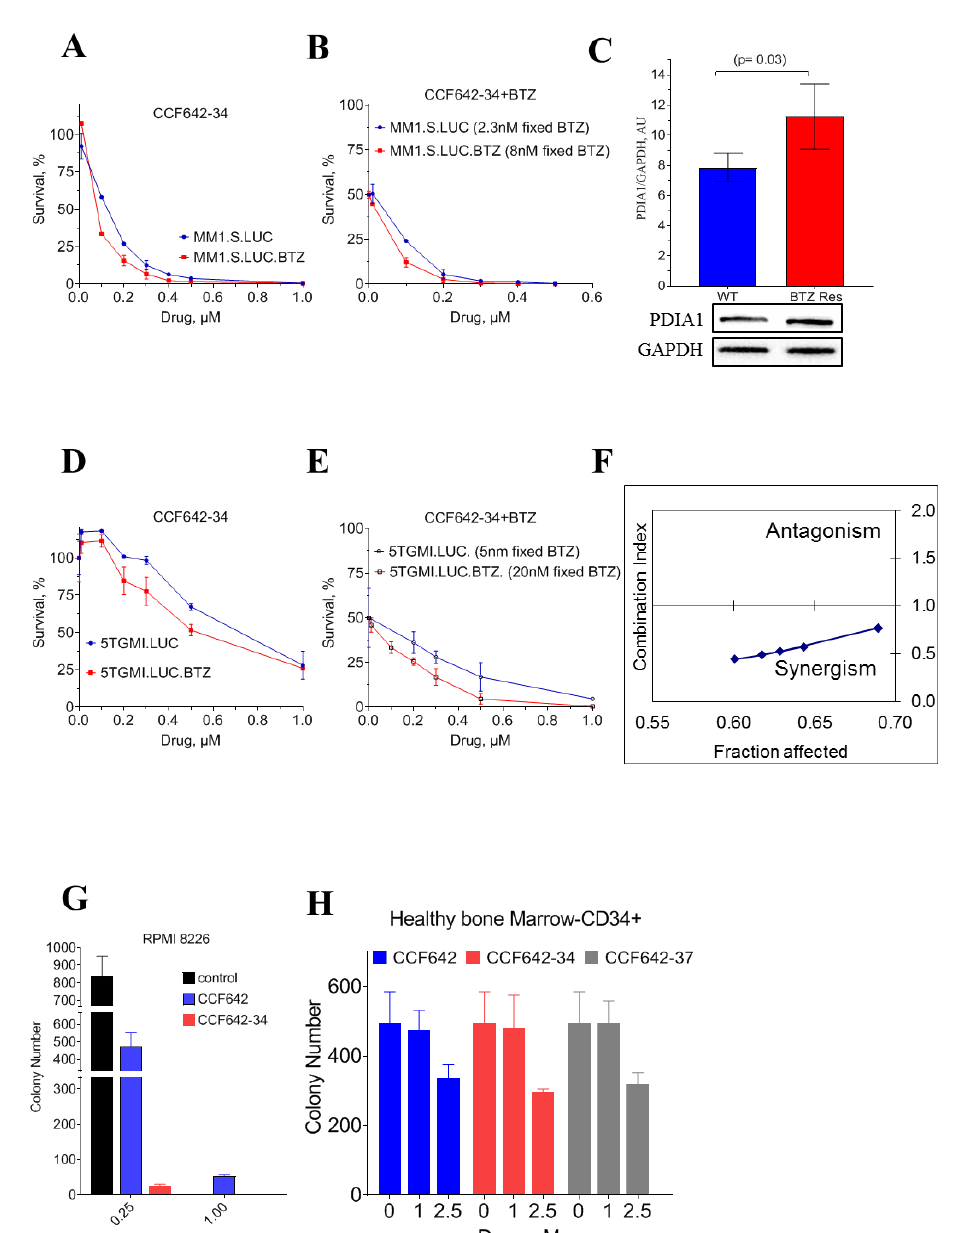
Figure 3. Selective cytotoxicity of PDIA1 inhibitor against multiple myeloma MM1.S cells. Cell viability and LD50 for inhibitors were measured in 96 well culture plates (2 × 10 4 cells/well) after 72 h of treatment using CellTiter-Glo ® Luminescent Cell Viability Assay (Promega, Madison, WI, USA). ( A ) Cell survival assay with MM1.S.luc and BTZ-resistant MM1.S.luc cells. ( B ) Bortezomib was used at a fixed IC50 concentration of 2 nM for MM1.S.luc, 8 nM for MM1S.luc BTZ for combined drug toxicity analysis. ( C ) Comparison of PDIA1 protein levels in MM1.S.luc and MM1.S.luc BTZ-resistant cells. Band intensity was calculated with Image Lab Version 5.2.1. ( D ) Cell survival assay with 5TGM1.luc and ( E ) BTZ-resistant 5TGM1.luc cells. ( F ) MM1.S cell line was exposed to CCF642-34, and BTZ for 72 h for synergistic drug combination test according to Chou and Talalay method. If the fraction of cells affected remained less than 1, the two drugs were determined as synergistic. ( G , H ) Toxicity of CCF642 and its analogues, CCF642-34 and CCF642-37, against RPMI 8226 and CD34 + normal bone marrow cells from healthy individuals in a colony-forming assay. The number of colony-forming units were plotted for each treatment. The toxicity against normal bone marrow was estimated at ~20-fold over the drugs against multiple myeloma